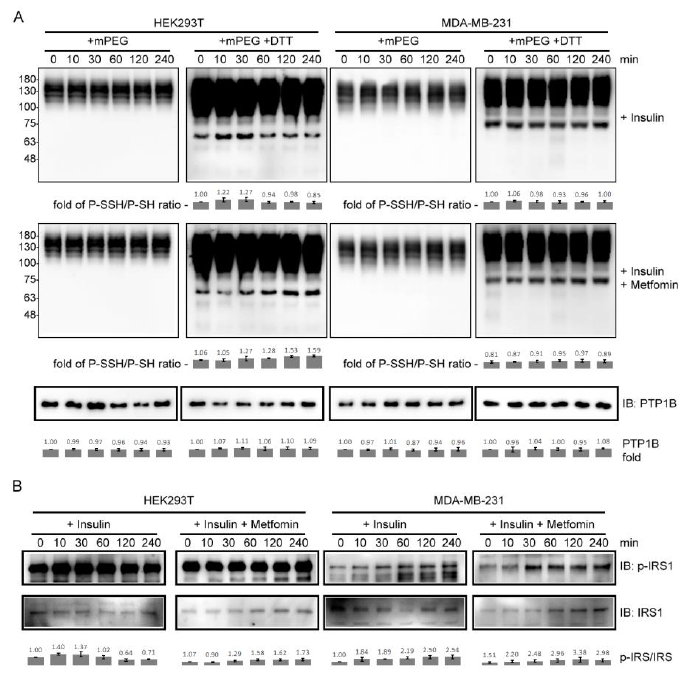
Figure 3. The levels of PTP1B S-sulfhydration and IRS1 phosphorylation in insulin- or combined insulin and metformin-treated HEK293T and MDA-MB-231 cells. ( A ) The immunoblots of PTP1B for detecting S-sulfhydrated PTP1B. ( B ) Immunoblots of phospho-IRS1 (p-IRS1) and IRS1. Insulin: 10 ng/mL insulin; metformin: 10 mM metformin (15 mM metformin for MDA-MB-231 cells). P- SSH/P-SH ratio was derived from dividing the value from lower band in the blot (+mPEG +DTT) by the value from corresponding band in the blot (+mPEG). p-IRS-1/IRS1 ratio was derived by dividing the value from band in the p-IRS1 blot by the value from corresponding band in the IRS1 blot. The fold change was derived by normalizing the value from each sample to that from the sample at 0 min (untreated control cells) ( n =